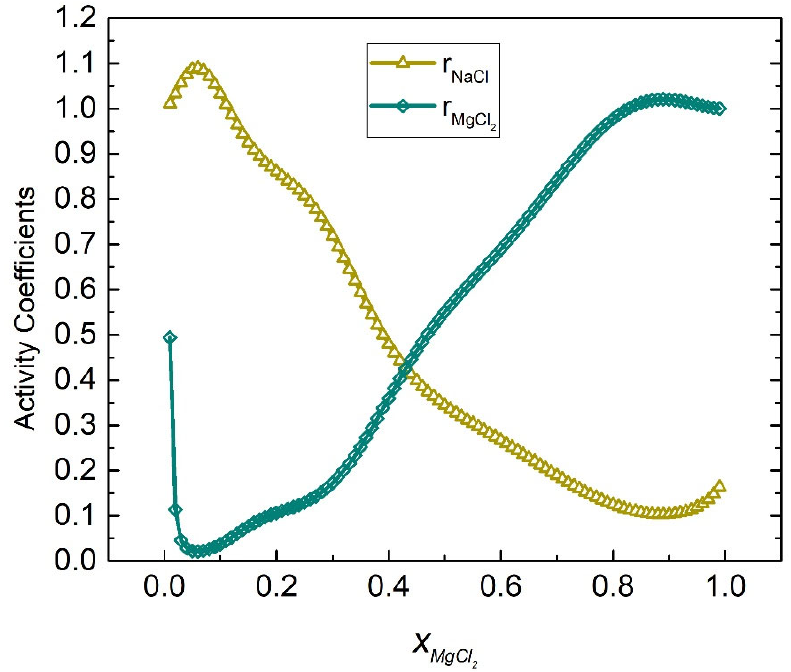
Figure 13. Calculated activity coefficients of each element of the NaCl-MgCl 2 system (1098 K).